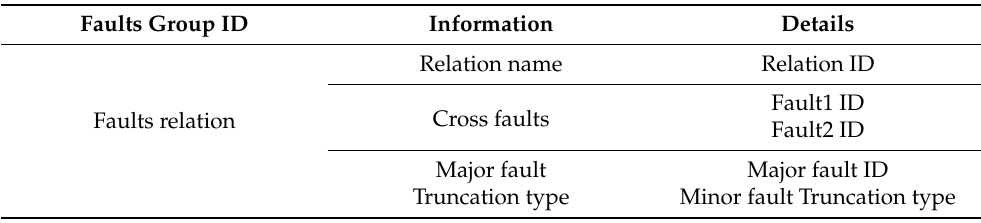
Table 2. Record Template of Faults Relationship